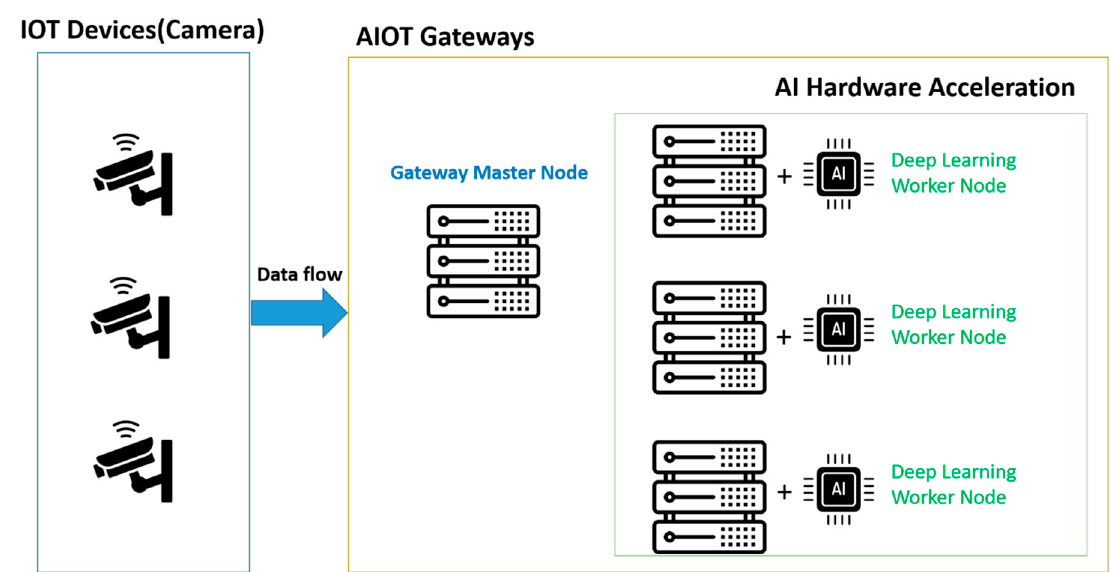
Figure 8. Cooperative Tracking between cameras.